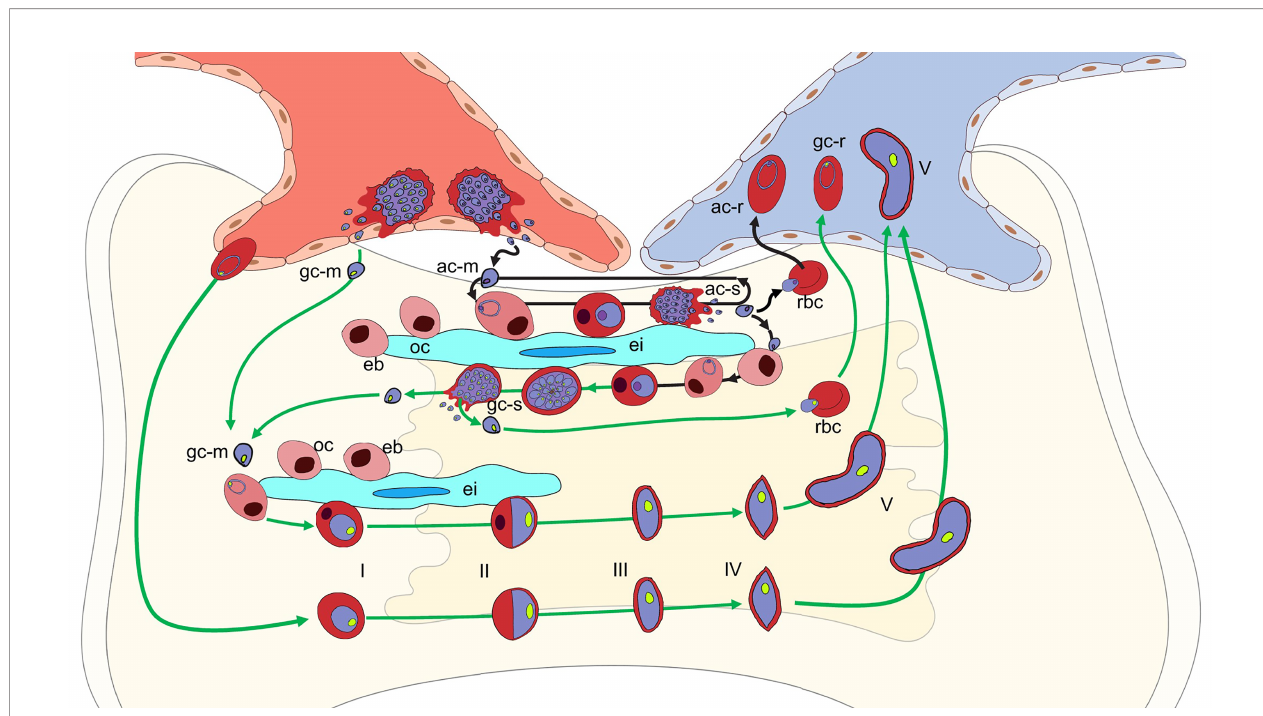
FIGURE 3 | Potential P. falciparum developmental pathways in the bone marrow parenchyma. Schematic of potential developmental pathways for asexually- committed (ac-m, purple nucleus), gametocyte committed (gc-m, green nucleus) merozoites, or erythrocytes containing ring stage parasites. The mechanisms involved in the parasite ’ s exit from the circulation, across the endothelial cells into the bone marrow parenchyma remains unclear. Once in the parenchyma where erythroblastic islands (ei) support developing erythroblasts (eb), the ac-merozoite (black arrows) could invade a developing erythroblast after the orthochromatic stage (oc) and continue to develop into either an ac-schizont (ac-s) (main arrow) or, although not shown for clarity, a gc-schizont (gc-s). The ac-merozoite could also invade a newly formed RBC and be released back into the blood stream as a ring stage parasite (ac-r). Likewise, an ac-merozoite generated in the parenchyma could also have the same three fates and these are indicated in the fi gure. The gc-merozoite (green arrows) from the blood or produced in the bone marrow could invade a developing erythroblast after it transitions to the orthochromatic stage (oc) and continue to differentiate into a mature gametocyte (V) that is deformable enough to be released back into the blood stream. As with the as-merozoite, the gc-merozoite could also invade a newly formed RBC and be released back into the blood stream as a gc-ring stage parasite (gc-r). If erythrocytes containing gc-rings enter the bone marrow, they could also continue to develop through the stiff immature stages to a deformable mature stage V gametocytes that could be released to the circulation. Although not shown due to space constraints, if erythrocytes containing gc-rings enter it is likely that erythrocytes containing ac-rings could also enter and continue development into ac- or